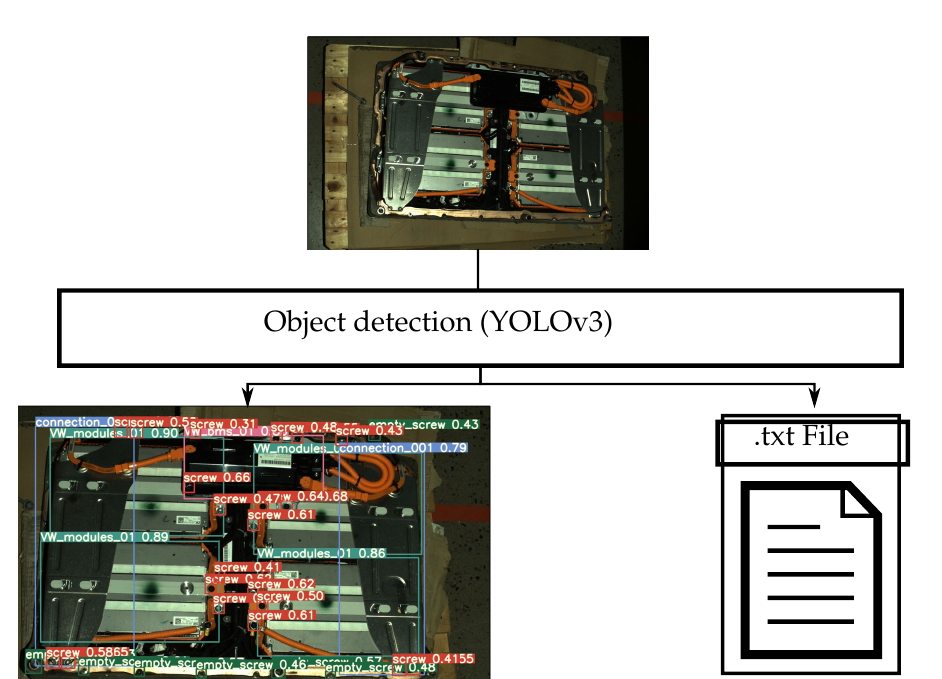
Figure 3. The YOLOv3 algorithm takes as input the 2D image of the EV Lithium-Ion Battery (EVB) pack, detects the components, finds the bounding box coordinates and class probabilities, and store the information in a text file. The labels shown on the picture have one color for each class.